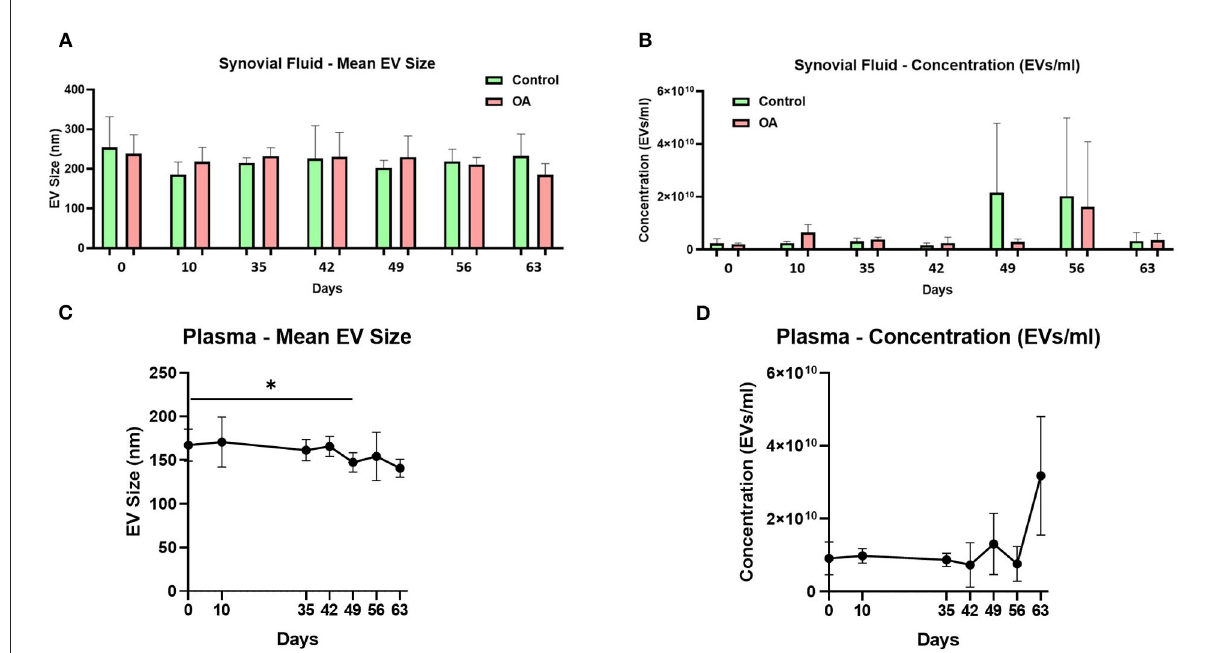
FIGURE1 Synovial fluid and plasma-derived extracellular vesicle size and concentration measured by nanoparticle tracking. (A) Mean size of extracellular vesicles isolated from synovial fluid control (green) and osteoarthritic (red) middle carpal joints prior to surgery (day 0) and on days 35, 42, 49, 56, and 63 following model induction. (B) Mean concentration of isolated extracellular vesicles in the synovial fluid. Synovial fluid samples were measured from all the horses ( n = 4) at all time points for control and OA joints. (C) Mean size of extracellular vesicles isolated from the plasma prior to surgery (day 0) and on days 35, 42, 49, 56, and 63 following model induction. (D) Mean concentration of isolated extracellular vesicles in the plasma. Plasma samples from all the horses ( n = 4) were measured at all time points. All the analyses were conducted by